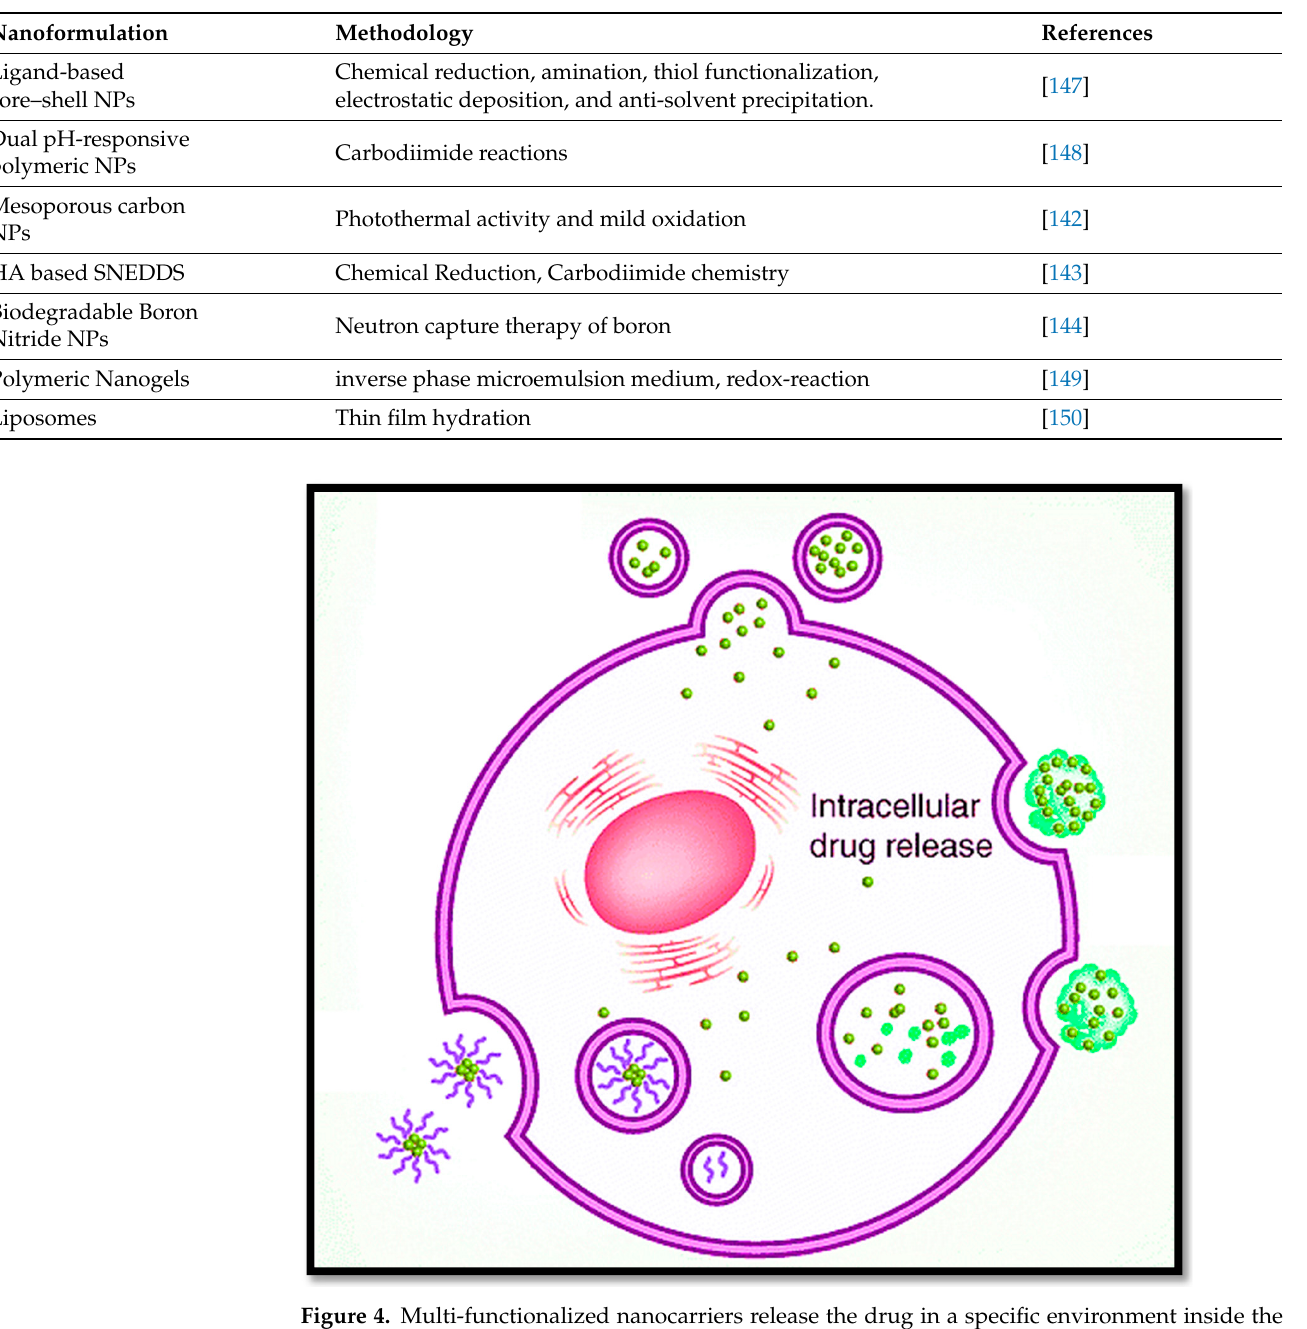
Table 2. Methods for nanostructures in the form of a detailed table with specific interest to BC.